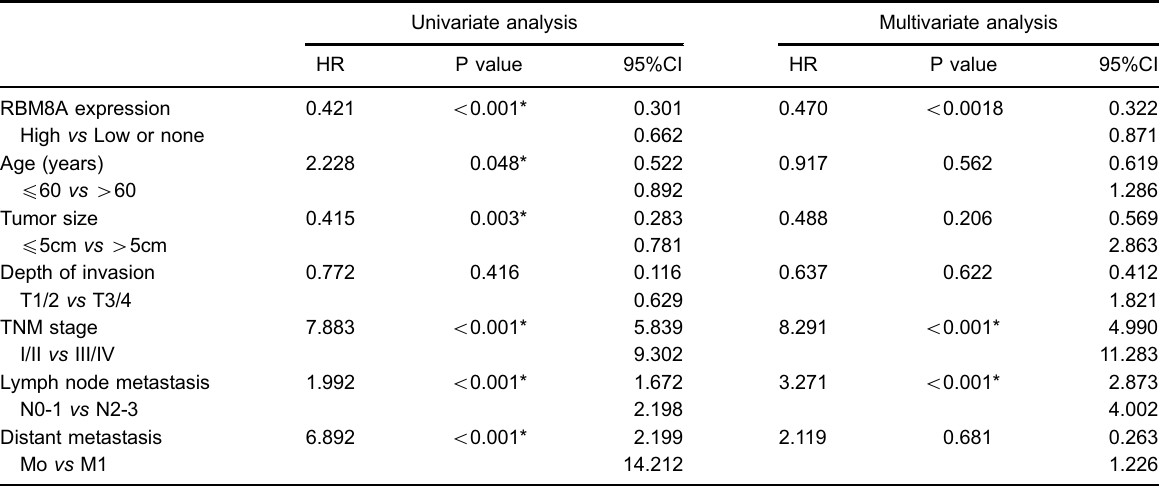
Table 2. Univariate and multivariate analysis of RBM8A for overall survival in patients with gastric